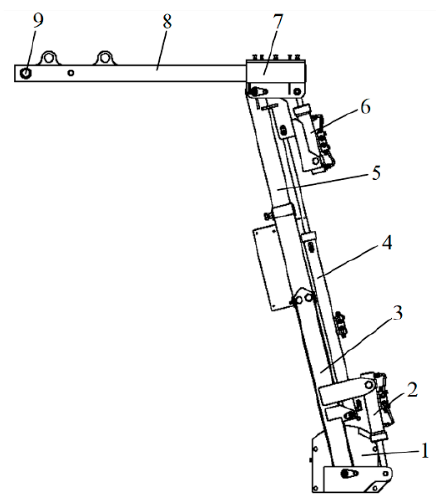
Figure 8. Structural diagram of shaping adjustment frame. (1) Fixed base for adjustment frame. (2) Following adjustment cylinder. (3) Outer sleeve for vertical beam. (4) Lifting hydraulic cylinder. (5) Inner sleeve of vertical beam. (6) Above adjustment cylinder. (7) Crossbeam locking assembly. (8) Crossbeam for adjustment frame. (9) Mounting holes for shaping and pruning frame.